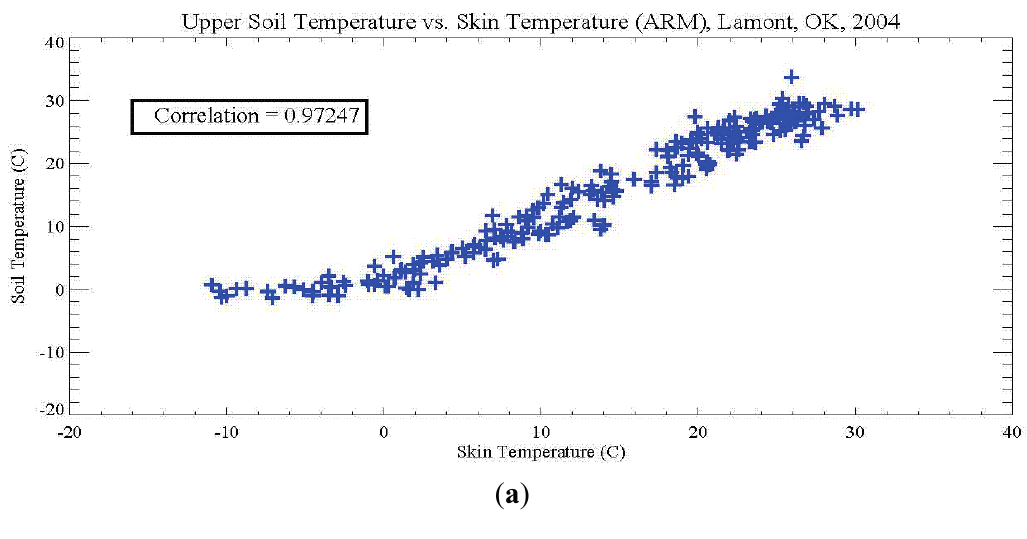
Figure 3. Soil temperature and skin temperature relations based on annual daily averaged ARM observation at Lamont OK site. ( a ) upper soil temperature vs . skin temperature, and ( b ) lower soil temperature vs . skin temperature. Data is daily mean during